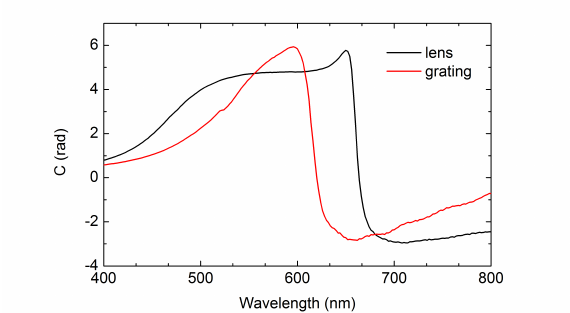
Figure 8. Circular retardance measured from the leakage wave of the lens and the